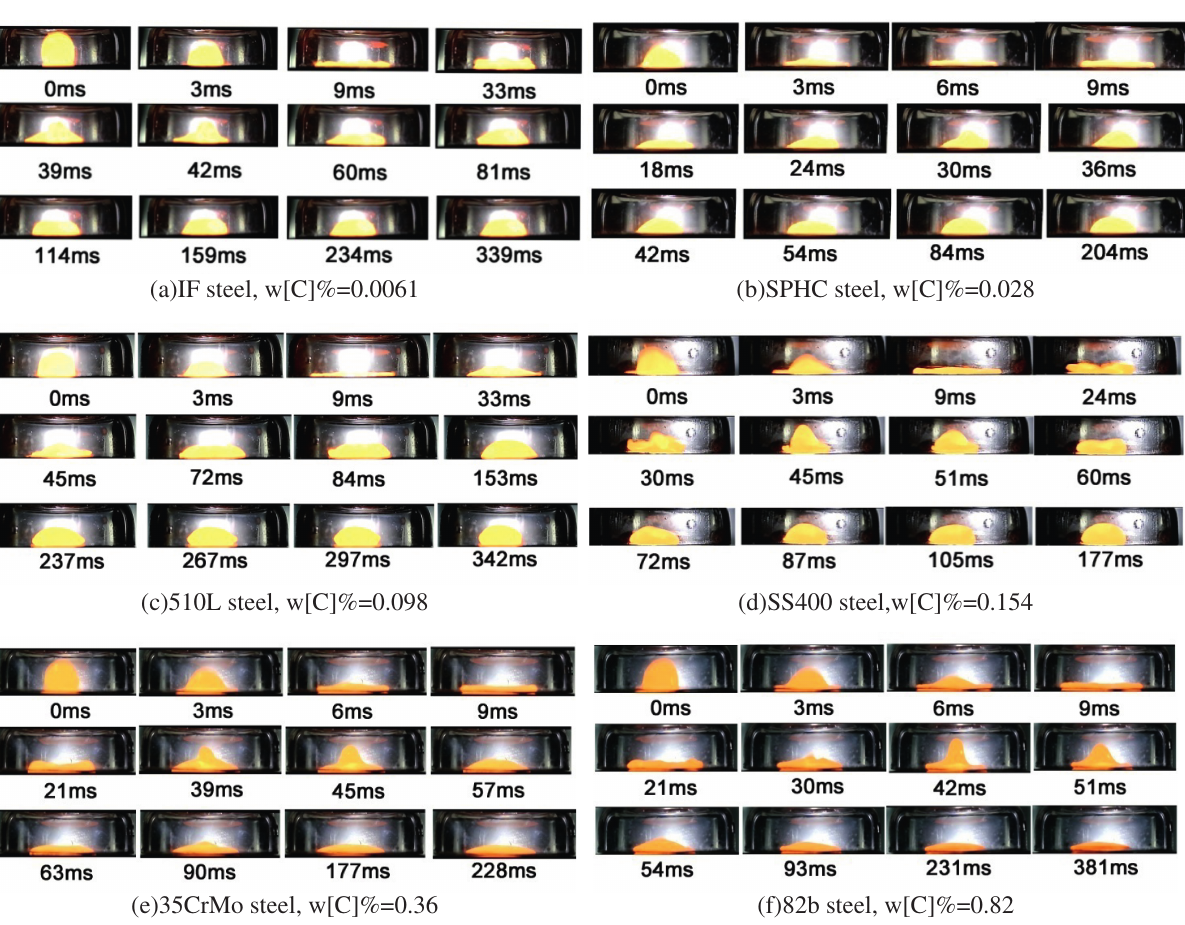
Figure 7: Difference of solidification and deformation of various steels at instant contact of steel droplet and the chill plate.